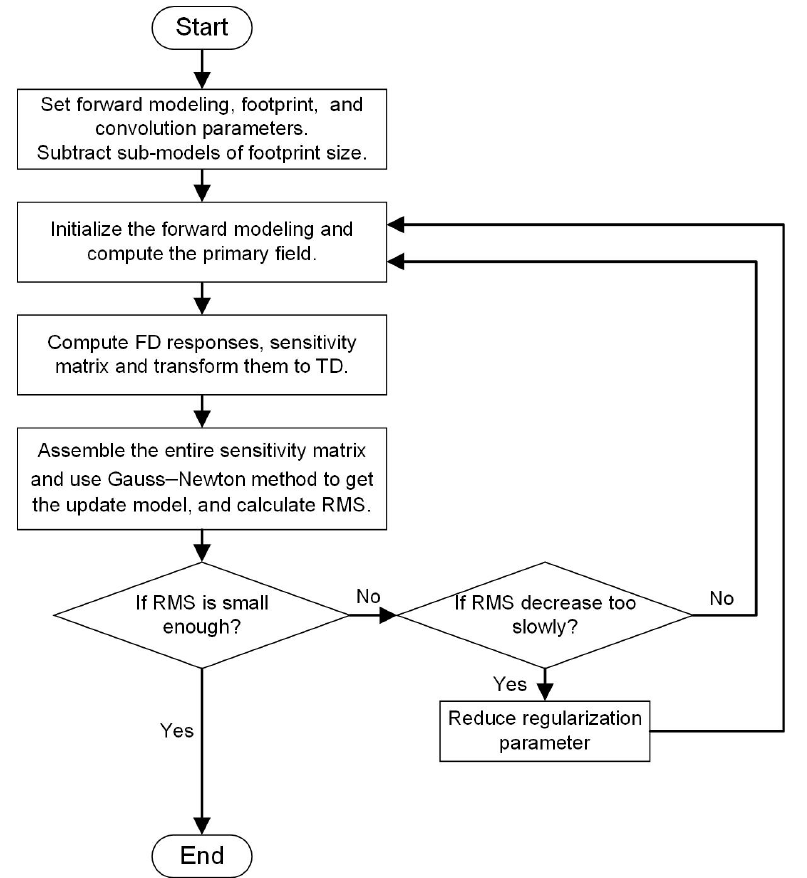
Figure 1. Workflow for time-domain (TD) airborne electromagnetic (AEM) inversion based on the “moving footprint”.